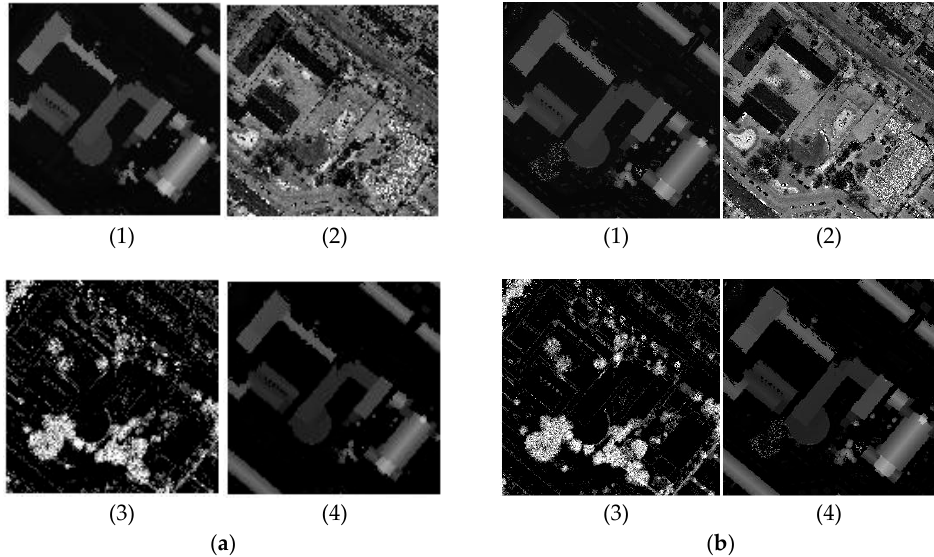
Figure 2. Subset of extracted images from different pixel sizes: ( a ) 1 m; ( b ) 0.5 m. Each image has four feature channels: (1) elevation, (2) intensity, (3) return number, and (4) height difference between the lowest point in a 20 × 20 m neighborhood, and the lowest point in a pixel. A higher resolution image captures more detailed structures.